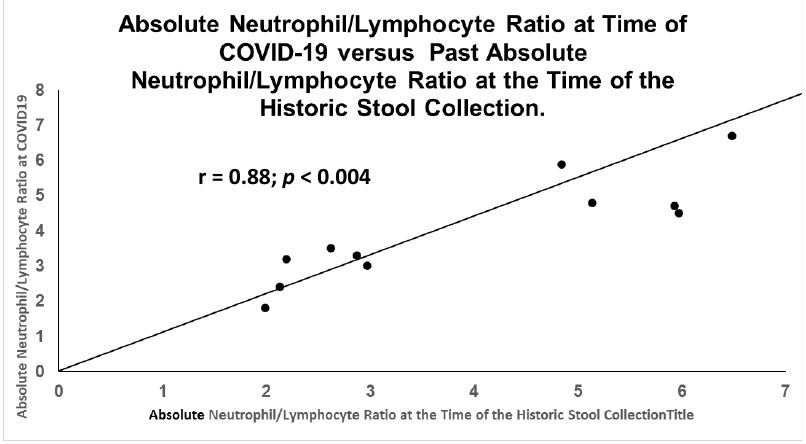
Figure 14. Direct significant correlation between sets of NLR obtained at time of initial stool collection and COVID-19.